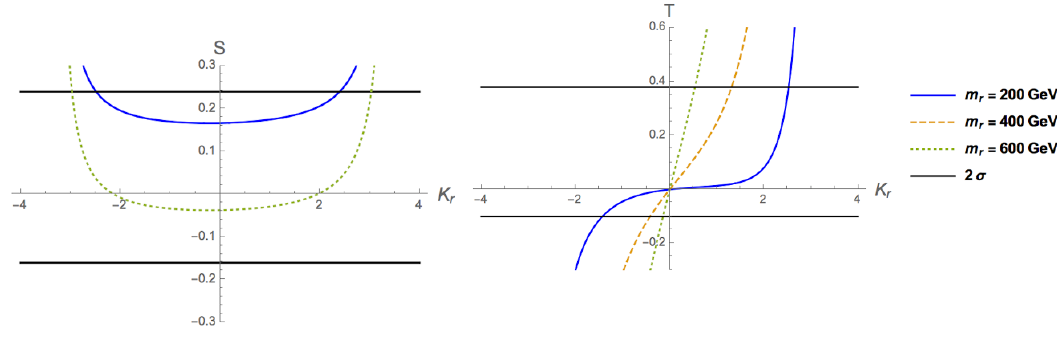
Figure 2 . S and T parameter curves as a function of the mixing parameter K r for di(cid:11)erent values of the radion mass. The solid horizontal black line represents the 2 (cid:27) upper bound from current value. The rest of the parameters chosen were cos( (cid:12) (cid:0) (cid:11) ) = 0, (cid:24) 2 = 0, tan (cid:12) = 1, m h = 125 GeV, m H = 1000 GeV, (cid:3) = 5 TeV and m A = 500 GeV. The dotted line in the S-plot corresponds to the single Higgs limit, without the H (cid:0) A loops included, for a radion mass of 200 GeV (it is very insensitive to the radion